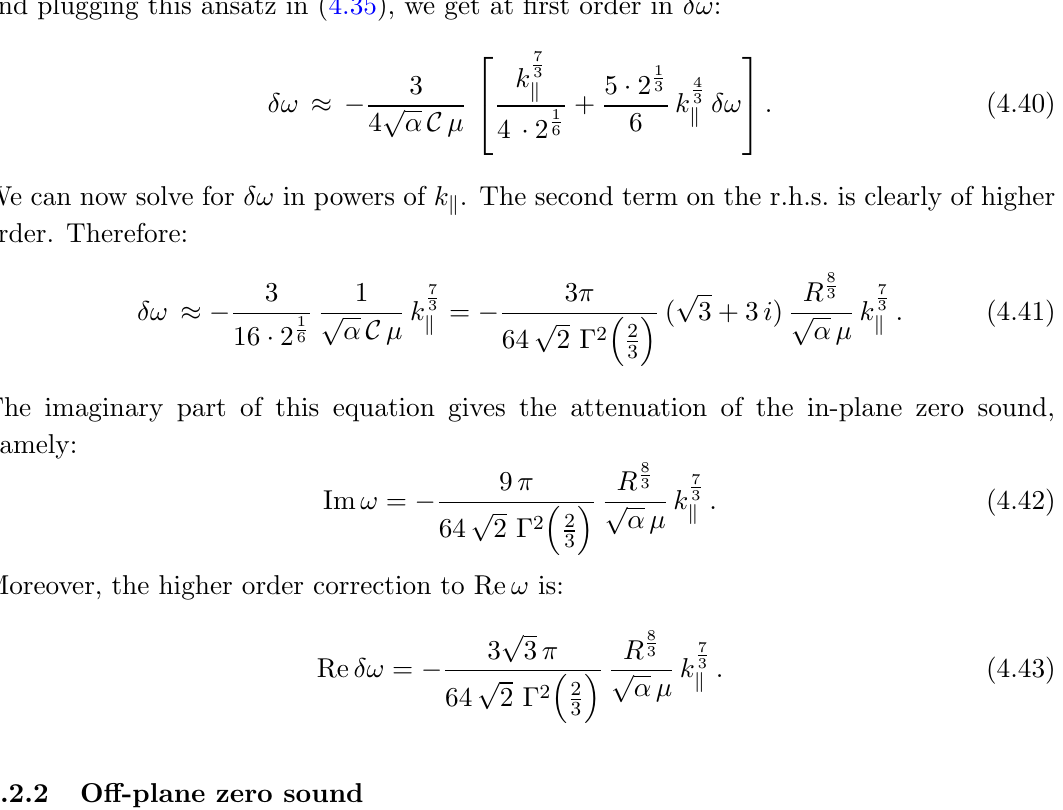
Figure 3 . We display the numerical dispersions (red curves) and the approximated dispersions obtained analytically (black dashed curves). On the left we show the results for the in-plane fundamental mode with analytics from (4.35). On the right we show the o(cid:11)-plane fundamental mode with analytics from (4.57). Di(cid:11)erent curves denote di(cid:11)erent temperatures: log (bottom-up), i.e., from highish to low temperature at (cid:12)xed density; see (4.79) for the de(cid:12)nition of the quantities with hats. All the numerical curves asymptote to unity on the vertical axis that correspond to di(cid:11)usion poles, marked by blue points. At high frequencies all the curves asymptote p to 3 and 0 for the in-plane (left panel) and o(cid:11)-planes (right panel) cases, respectively, though this is not visible in the plotted